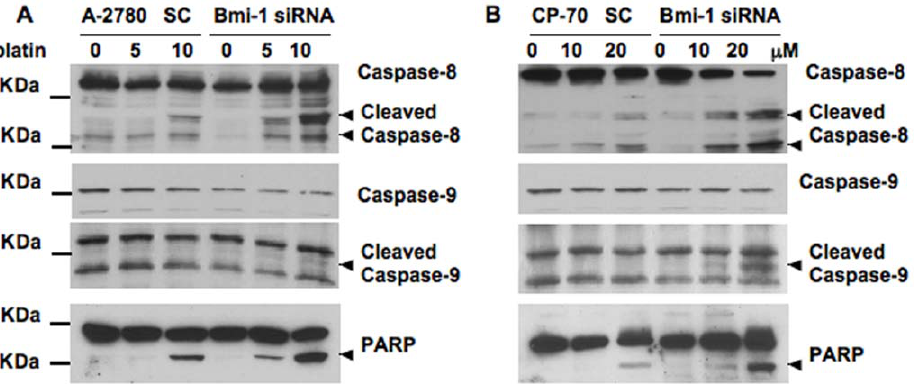
Figure 5. Effect of Bmi-1 knockdown on apoptotic markers. Ovarian cancer cells transfected with scrambled control or Bmi-1 siRNA were treated with or without cisplatin for 48 h. Western blot was performed for caspase-8, caspase-9 and PARP using respective